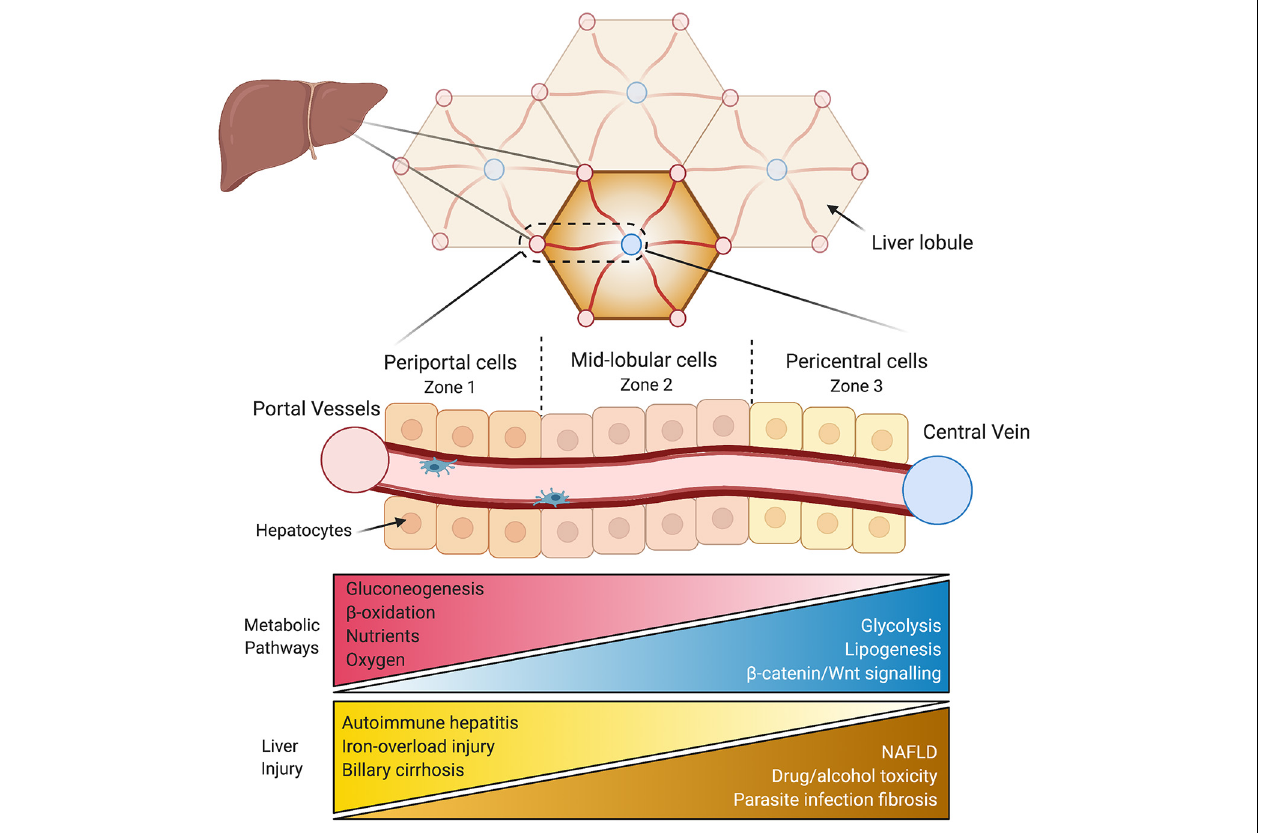
FIGURE 1 | Liver anatomy and the hepatic lobule. The liver is composed of hexagonal units called lobules. Oxygen and nutrient rich blood flows directionally from the hepatic vessels (red) in the corners of the lobule toward a central vein in the middle (blue). Periportal hepatocytes (zone 1) are at the periphery of the lobule, followed by mid-lobular cells, and finally pericentral hepatocytes surround the central vein (zone 3). The variable microenvironment along the periportal-pericentral axis results in graded gene expression and the spatial separation of certain metabolic processes to periportal (red) and pericentral (blue) regions. Certain liver injuries are also zone-dependent, with some originating or confined to periportal (yellow) regions and some to pericentral regions of the lobule (brown). NAFLD, non-alcoholic fatty liver